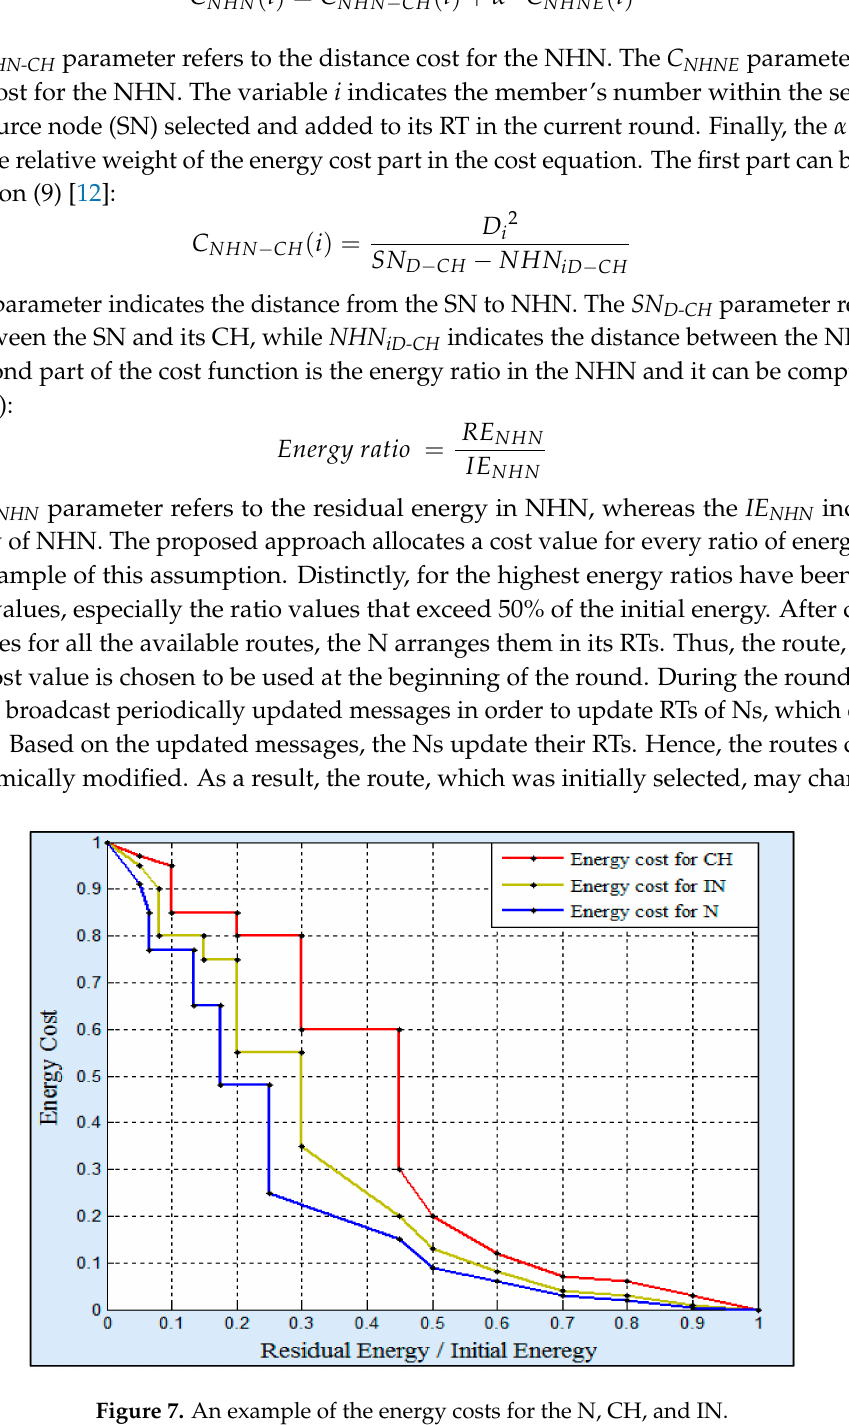
Figure 7. An example of the energy costs for the N, CH, and